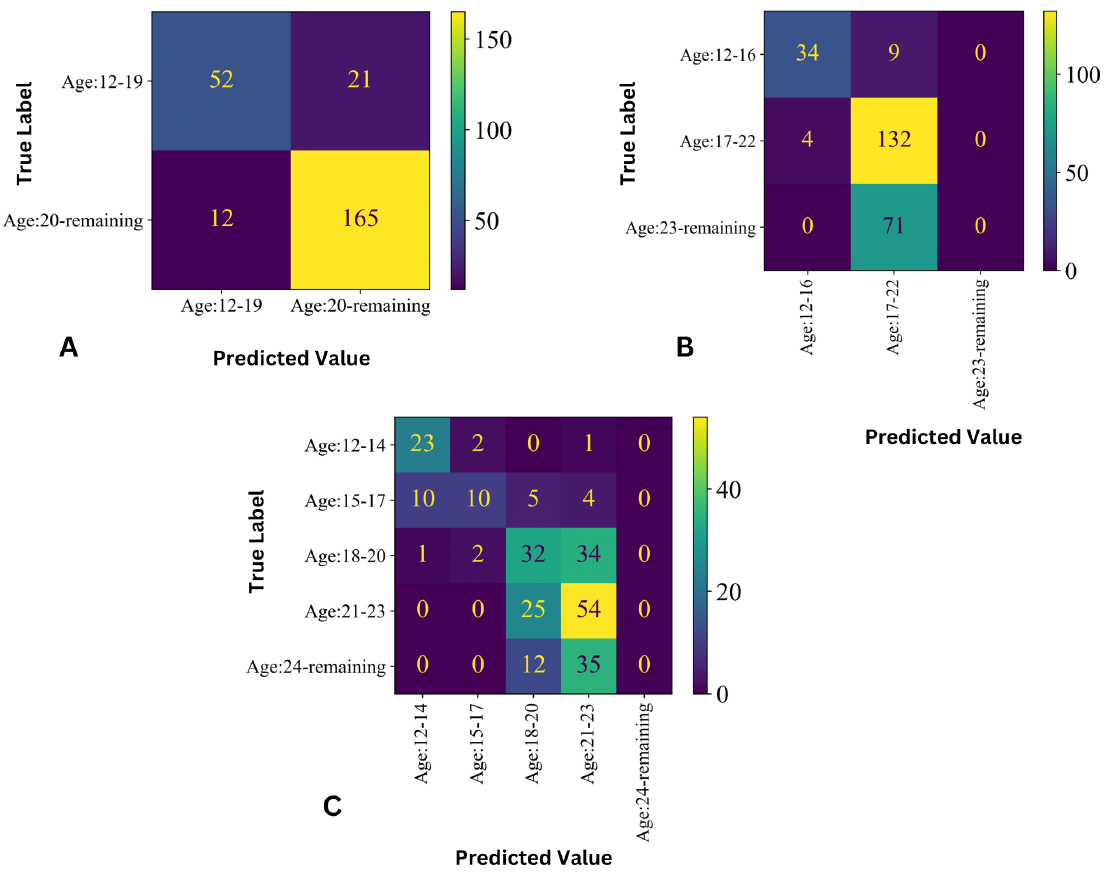
Figure 5. Confusion matrix from the best predictive model: ( A ) 2–Class prediction, ( B ) 3–Class pre-